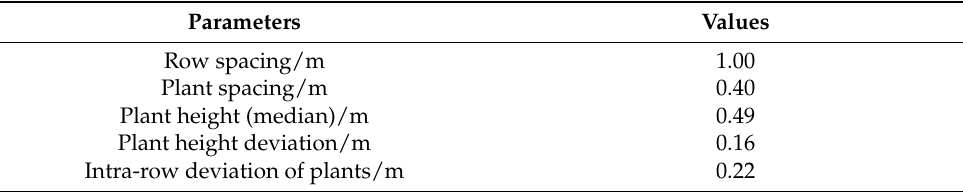
Table 4. Measurement results of relevant parameters in the test field.